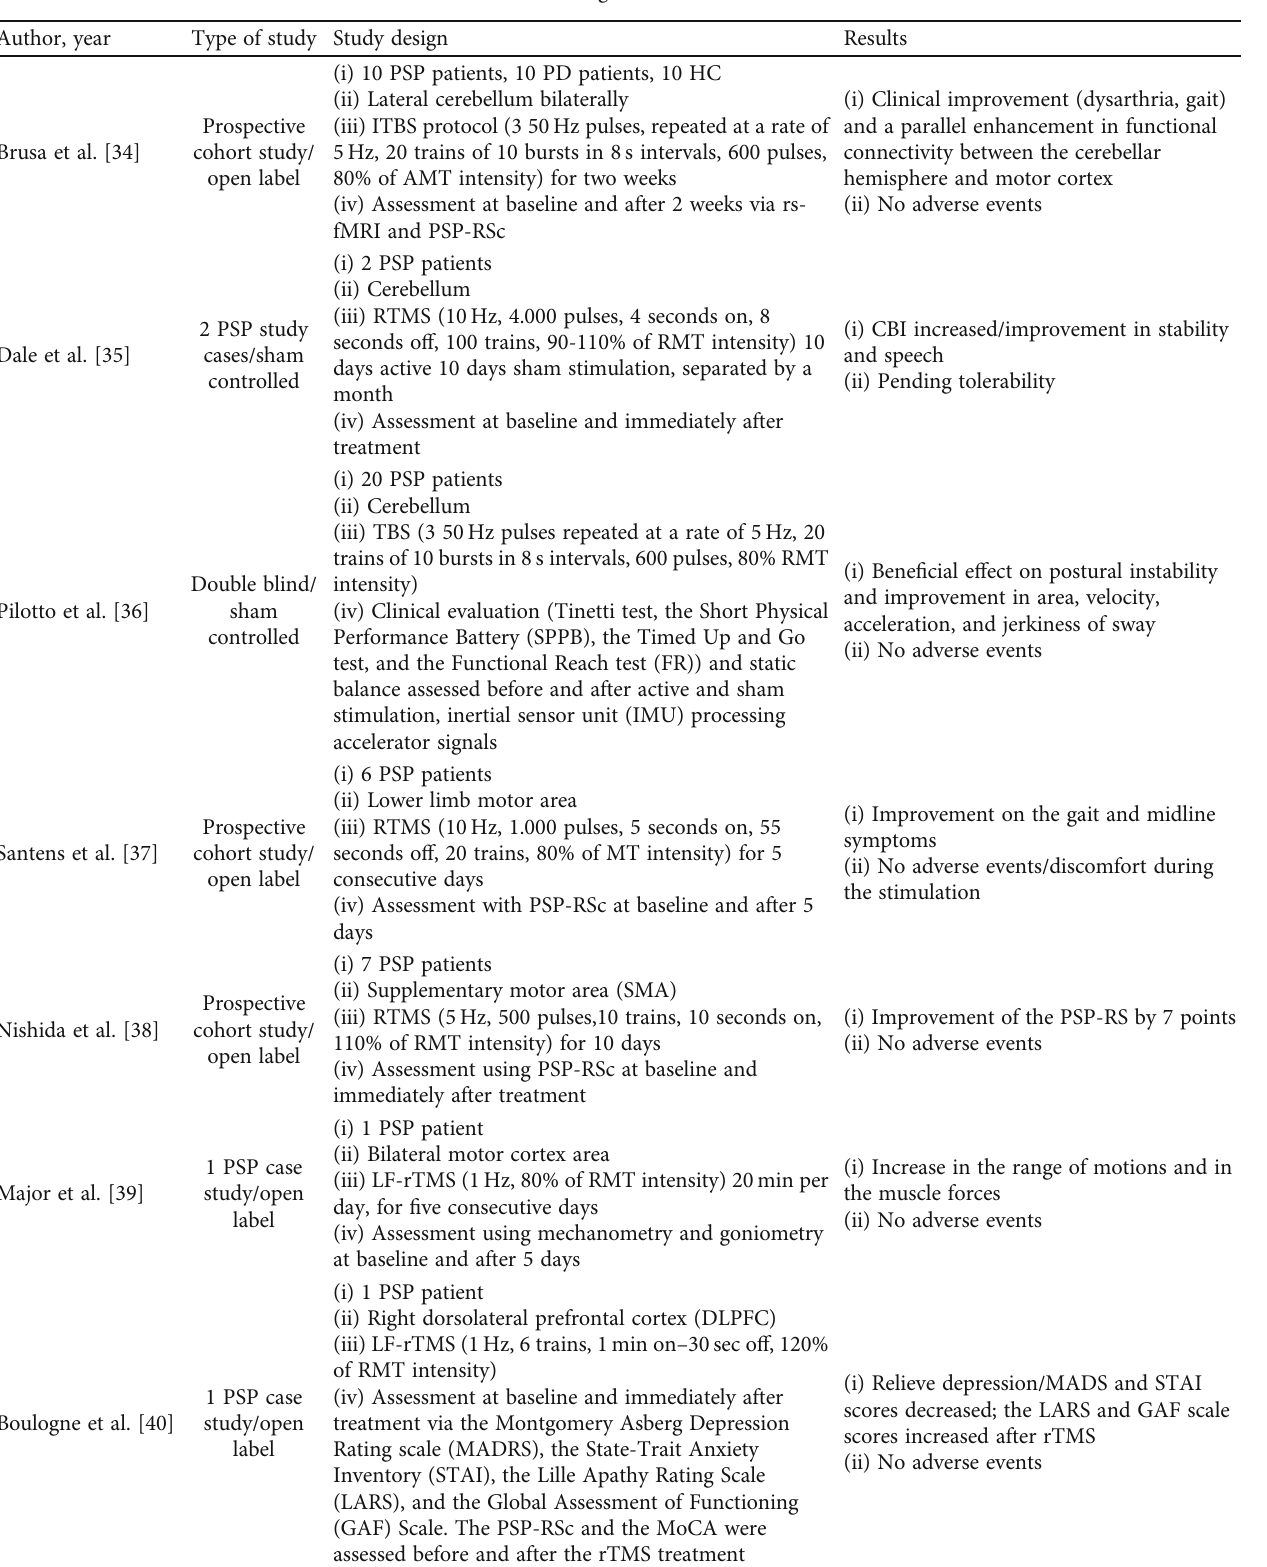
Table 1: Studies assessing the e ff ects of rTMS in